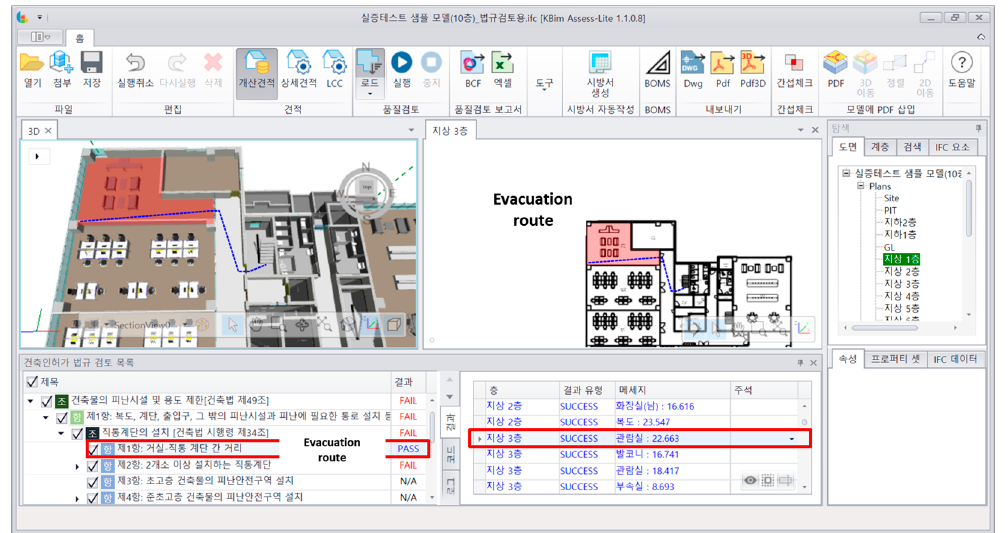
Figure 12. Code checking screen: evacuation stairs’ conditions.